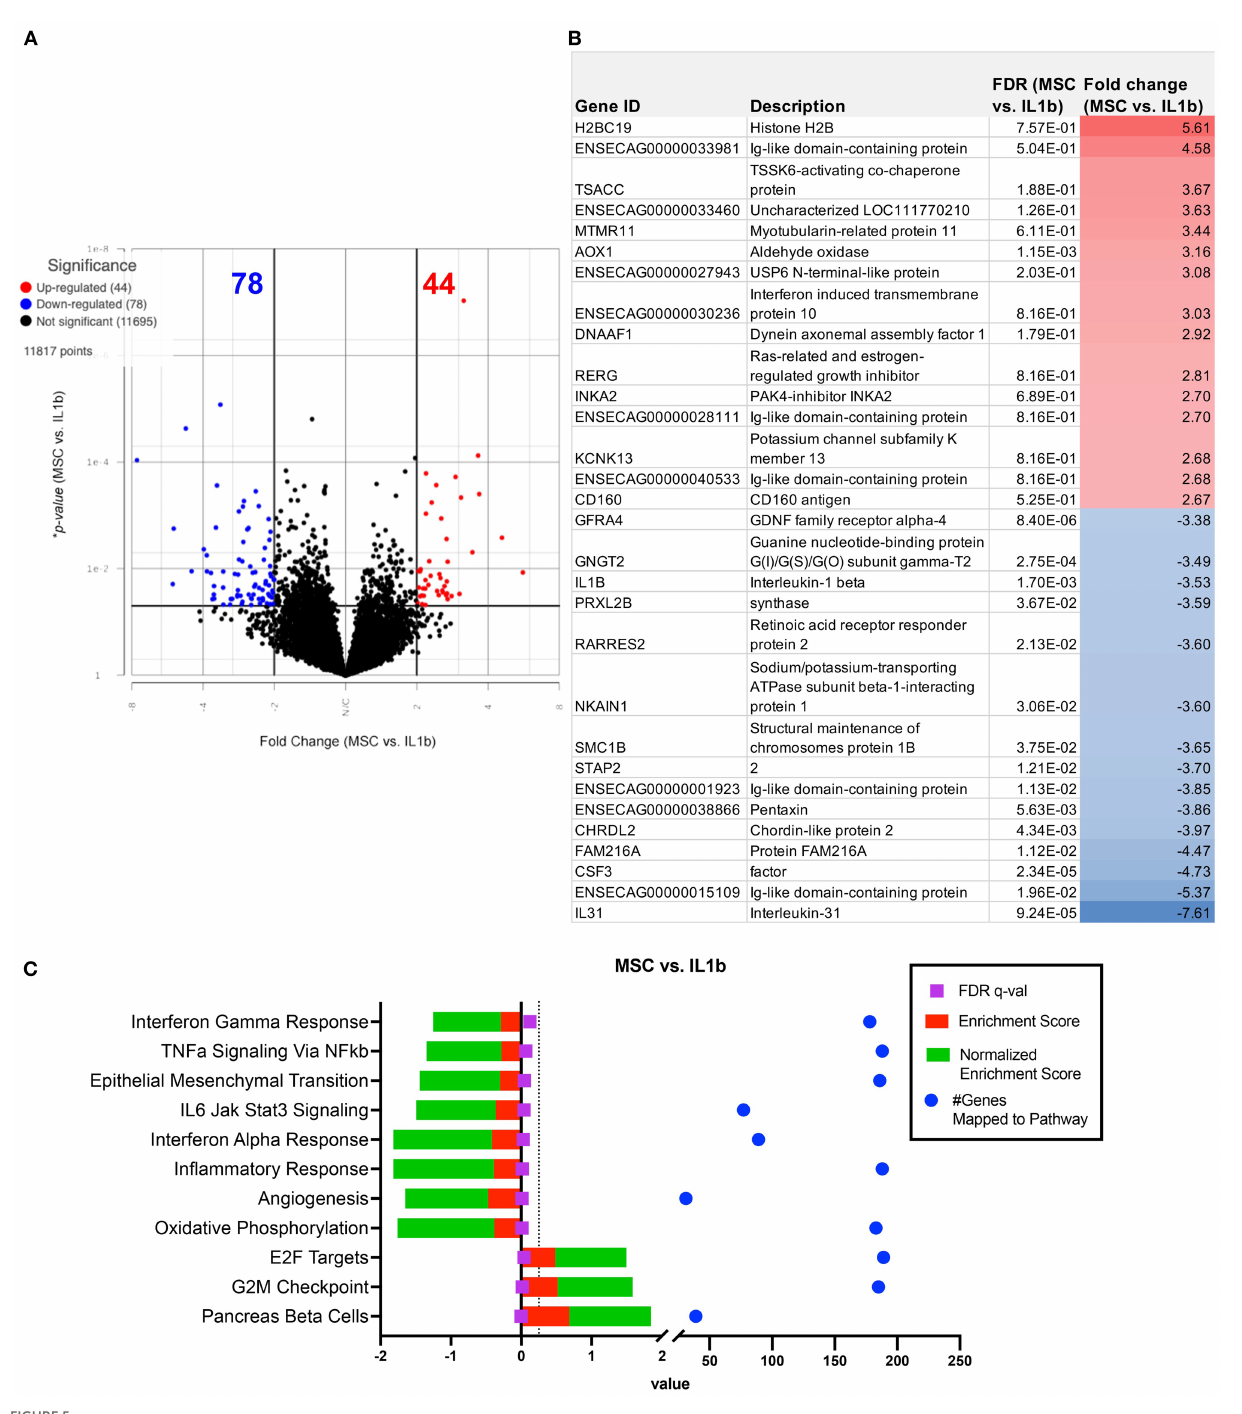
FIGURE5 Differential gene expression and pathway analysis of MSC supernatant conditioned macrophages compared to IL-1ß stimulated. (A) Volcano plot of MSC treatment vs. IL-1ß. X-axis shows fold change and y-axis shows unadjusted adjusted p -value. Significance defined as p -value ≤ 0.05 fold change ≥ 2 or ≤ − 2. (B) List of genes, description, *unadjusted p -value and fold change of top 15 upregulated and downregulated genes in differential analysis results from MSC supernatant treated vs. IL-1ß stimulated samples. (C) GSEA results using normalized counts from n = 3 MSC supernatant treated vs. IL-1ß stimulated macrophages. Legend shown in box to